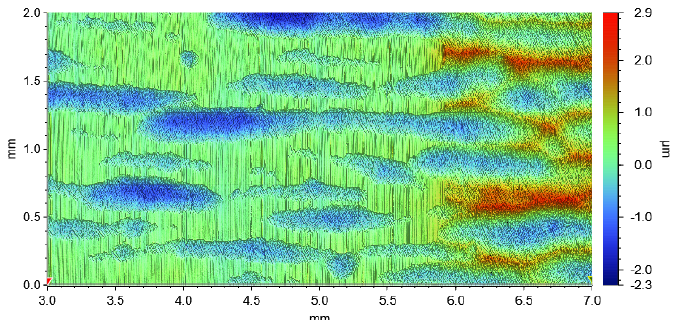
Figure 13. WLI image of disc with wear marks on the left, and original surface topography after finishing on the right.